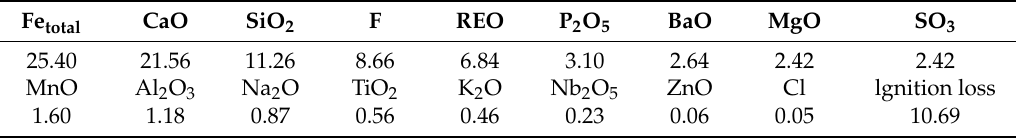
Table 1. Chemical composition of the rare earth flotation tailing (%, mass